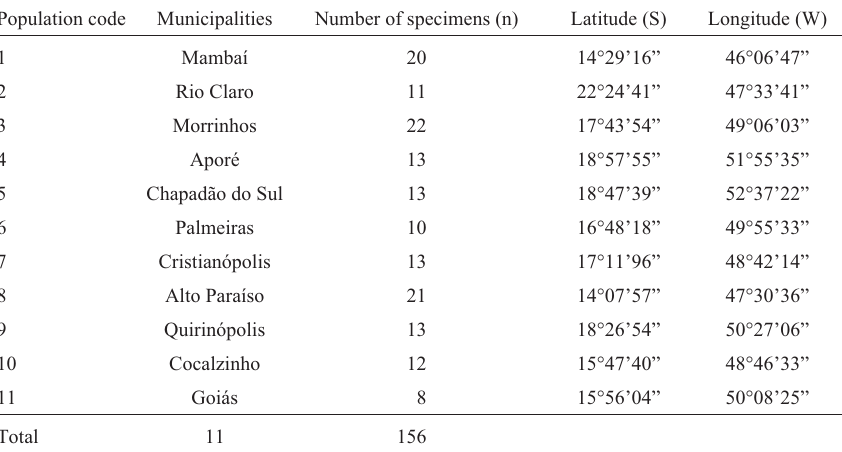
Table1 -The11local Eupemphixnattereri populationsanalyzed,samplesizes,municipalitiesintheBrazilianstateofGoiásandthegeographicalcoordi- nates. Population